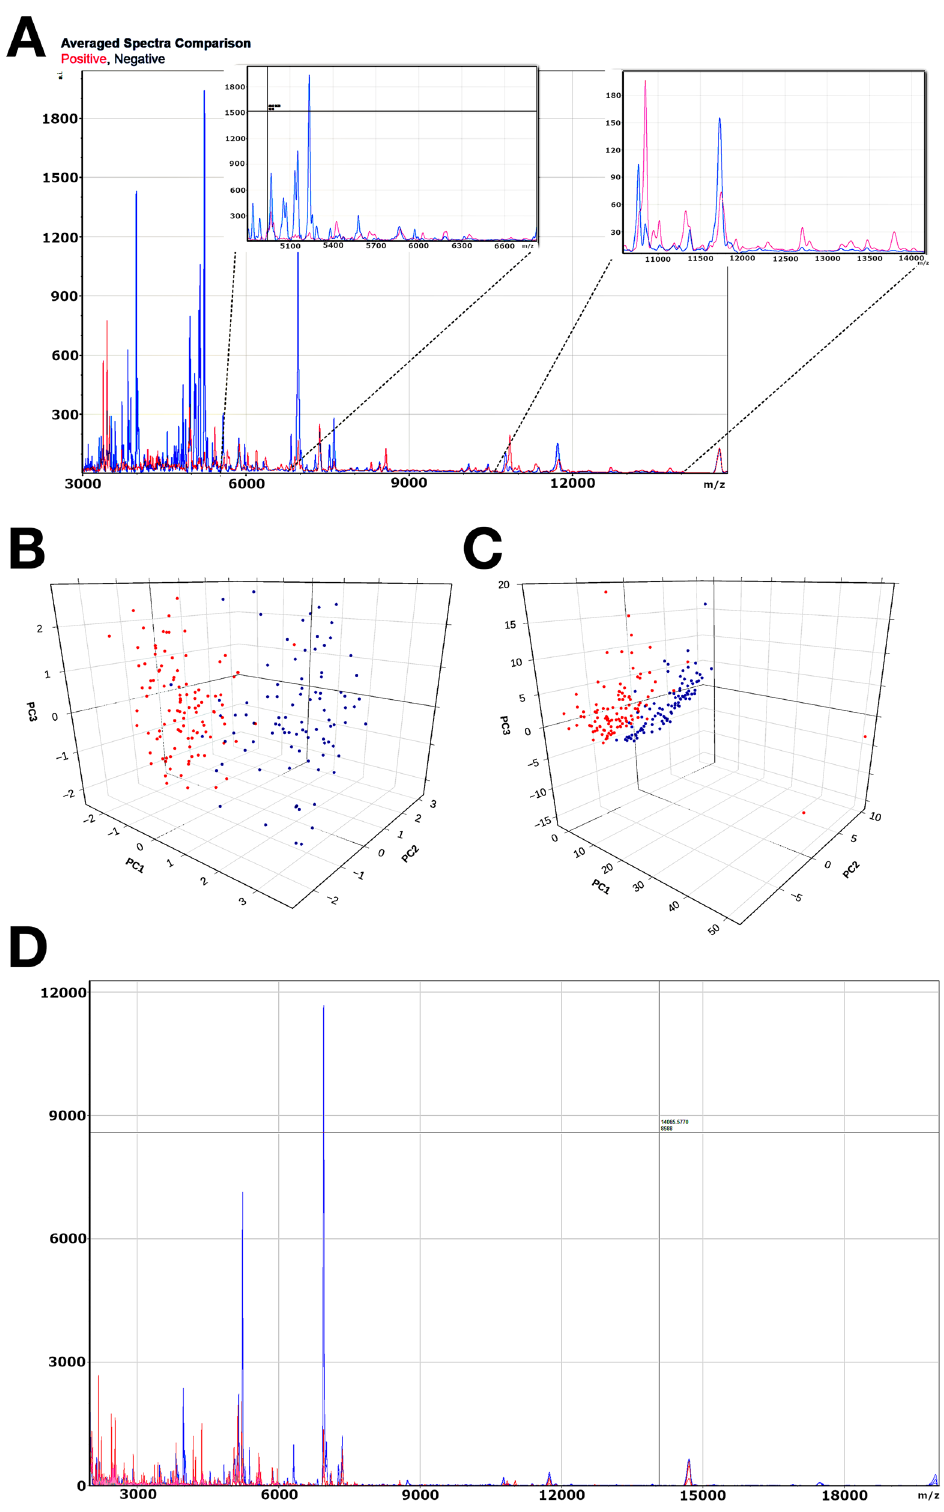
Figure 4. Example MALDI-TOF-MS spectra and PCA analysis of COVID-19 positive vs. negative samples. ( A ) Illustrates the average MALDI-TOF-MS spectra for patients that were SARS-CoV-2 RNA PCR positive (pink) versus PCR negative (blue). Zoomed in regions of interested are also shown. X-axis is mass to charge (m/z) ratio and Y-axis is relative abundance. ( B , C ) Show unscaled and scaled PCA, respectively, for the 199 samples (red = positive, blue = negative) tested by the MALDI-TOF-MS method. ( D ) A pair of example (COVID-19 positive vs. negative)